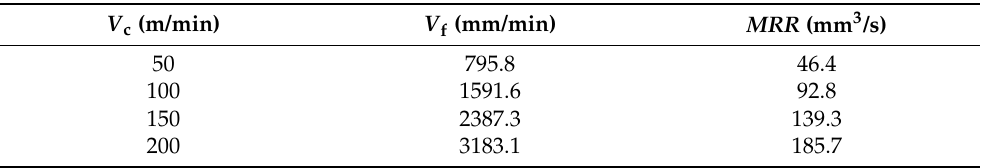
Table 1. The values of feed speed ( V f ) and material removal rate ( MRR ) against the four levels of cutting speed ( V c ) and feed rate of 0.1